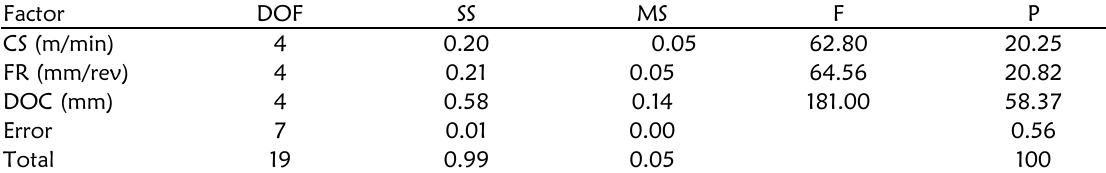
Table 15: ANOVA for tool wear, Tw (mm)